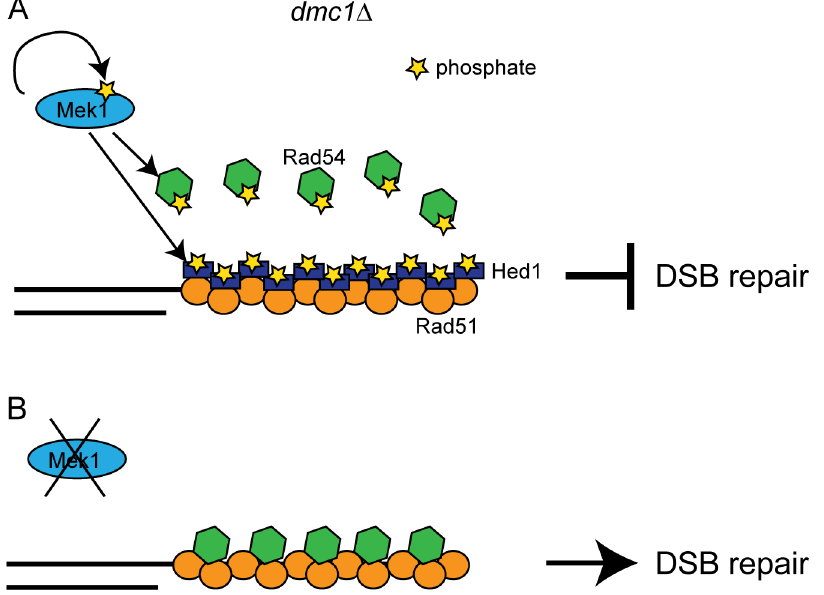
Fig 7. Mek1 inhibits Rad51 activity in dmc1 Δ diploids by phosphorylation of both Rad54 and Hed1. (A) In the absence of DMC1 , active Mek1 phosphorylates both Rad54 and Hed1, as well as itself. Rad54-Rad51 complex formation and strand invasion activity are prevented because phosphorylated Rad54 has decreased affinity for Rad51 and Hed1 bound to Rad51 excludes Rad54. Mek1 remains constitutively active by autophosphorylation. This is a cartoon and not meant to indicate any particular stoichometries between the proteins. (B) Inactivation of Mek1 results in degradation of Hed1 and dephosphorylation of Rad54, thereby allowing Rad51-Rad54 complex formation and DSB